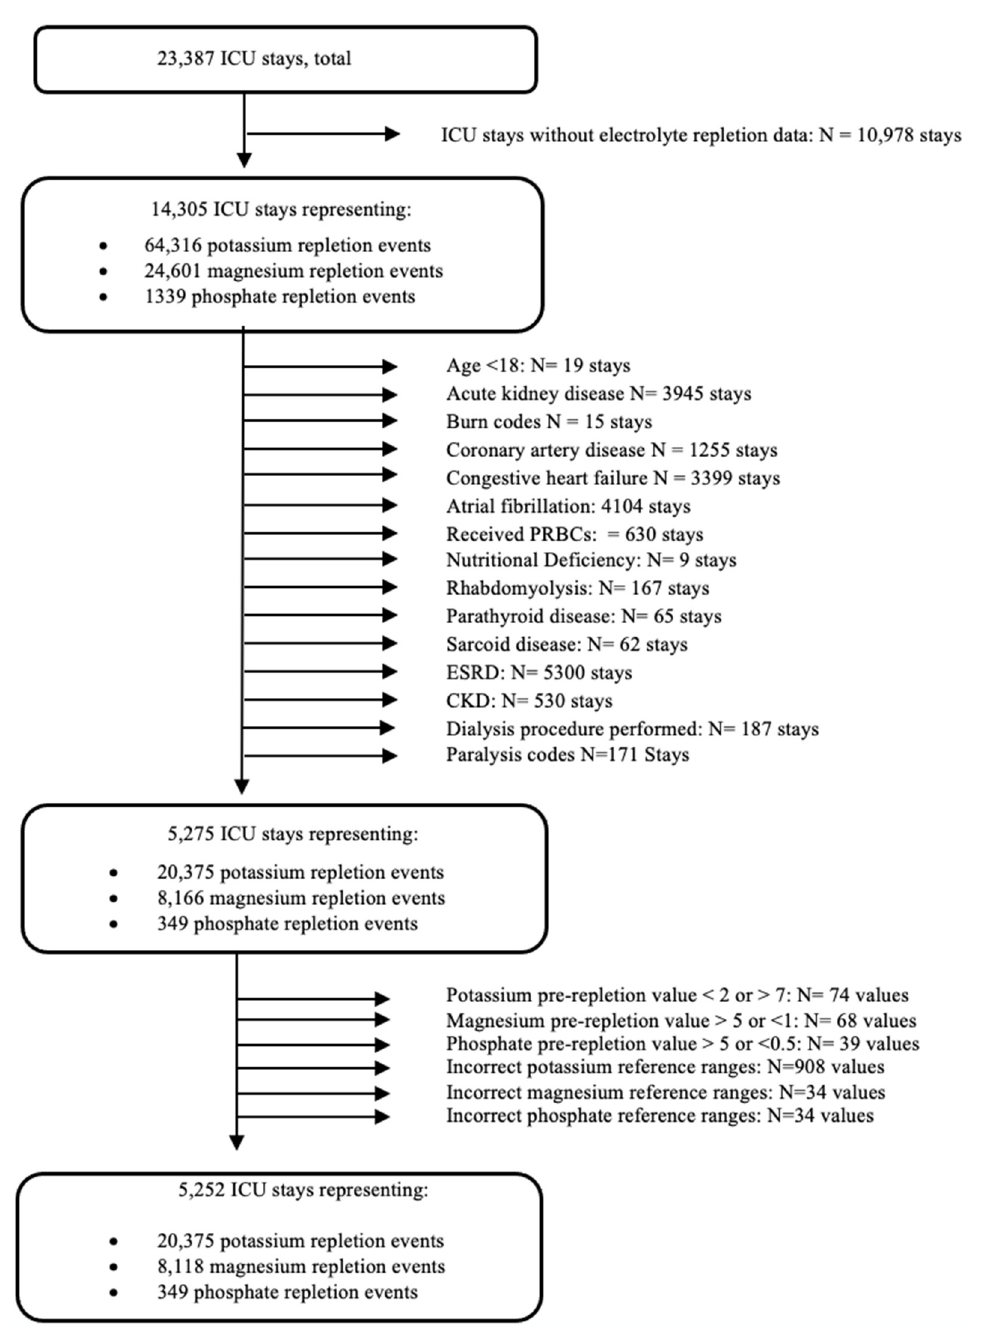
Figure 1. The structure of the data analysis. Consequently, events involving the transfusion of packed red blood cells ( n = 630), rhabdomyolysis ( n = 1167), a parathyroid disease of any kind ( n = 65), sarcoid disease ( n = 62), chronic kidney disease ( n = 530), acute kidney disease ( n = 33,945), and end-stage renal disease ( n = 5300) were eliminated. Additionally, encounters where the patient had coronary artery disease ( n = 1255), congestive heart failure ( n = 3399), atrial fibrillation ( n = 4104), nutritional deficiency ( n = 9), and paralysis ( n = 171) were excluded